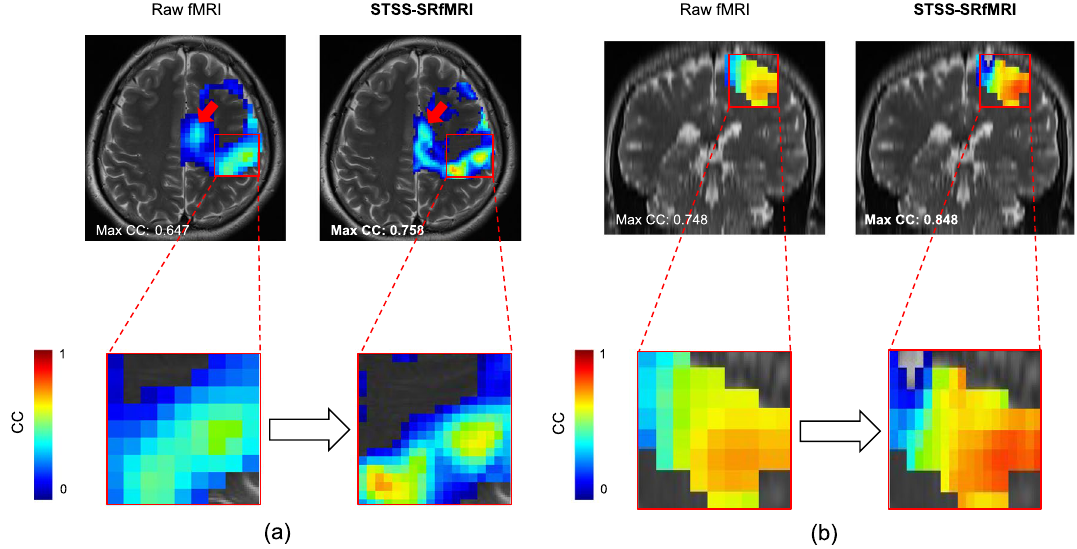
Figure 4. Example comparing the cross-correlation (CC) maps obtained from the raw unpreproccessed fMRI data and the Static T2*WI-based Subject-Specific Super Resolution fMRI (STSS-SRfMRI) for one subject: ( a ) the maps in the raw axial plane, and ( b ) the sagittal plane reconstruction for the same case. The areas having the highest CC values in the primary motor cortex are magnified below to showcase the details. In a visual comparison, the highly correlated area in the STSS-SRfMRI maps occupied a relatively limited area in comparison to the raw fMRI map. The red arrows in ( a ) point to the supplementary motor cortex, which appears more sharply defined in the STSS-SRfMRI